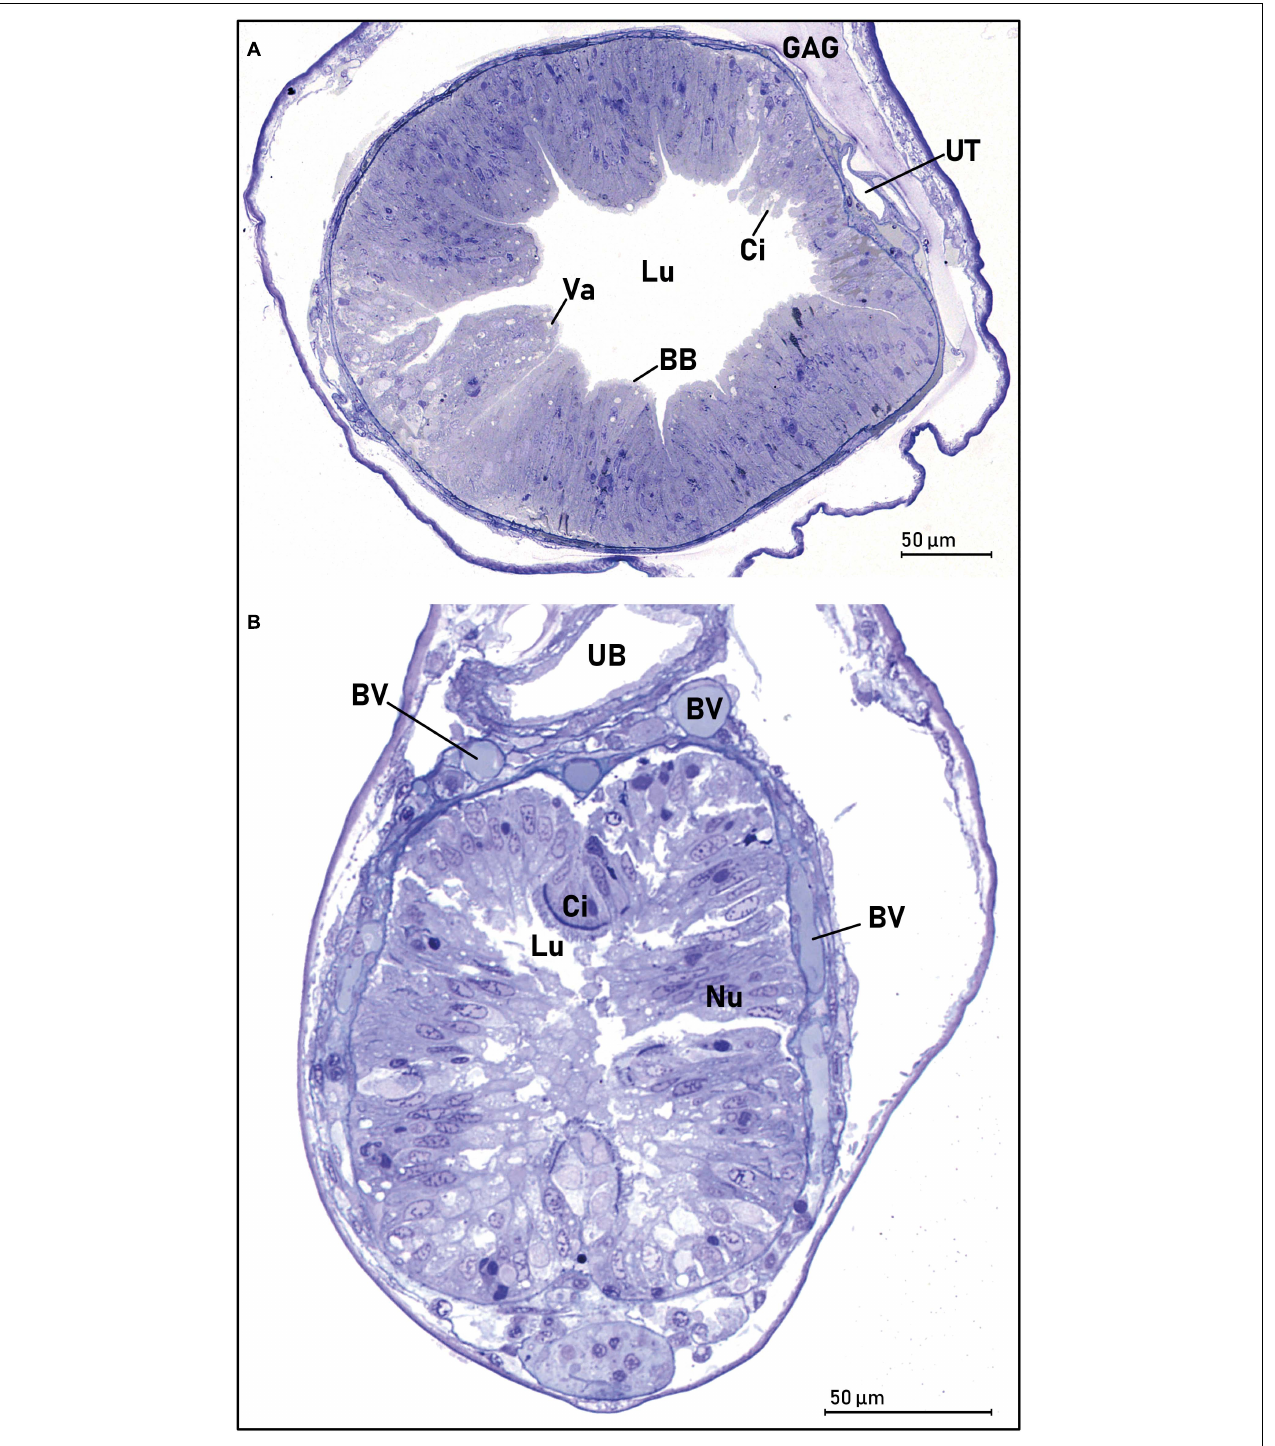
FIGURE 9 | Transverse sections of the middle intestine (A) and the hindgut/anus (B) of a European eel larva ( Anguilla anguilla ) (L21, SL = 23.33). (A) The lumen (Lu) is wide, and the mucosa is folded in several villi, with an absorptive epithelium of oblong columnar cells with a microvilli brush border (BB). The dorsal part had a thinner intestinal wall, where some scattered cilia were observed. Some absorptive vacuoles were observed especially in the apical part of the enterocytes (Va). The kidney/nephric tubules were united to form a urinary tract (UT). (B) The thick intestinal wall of the hindgut/anus, consisting of columnar epithelium and the microvilli brush border. There was a very distinct area of ciliated (Ci) cells in the dorsal part of the gut epithelium. The urine bladder (UB) is visible dorsally to the intestine. The “submucosal” part of the hindgut was very vascular, and several blood vessels (BV) were visible. Abbreviations: BB, microvilli brush border; BV, blood vessels; Ci, ciliated cells; Lu, lumen; Nu, nucleus; UB, urine bladder; UT, urinary tract; Va, vacuoles.